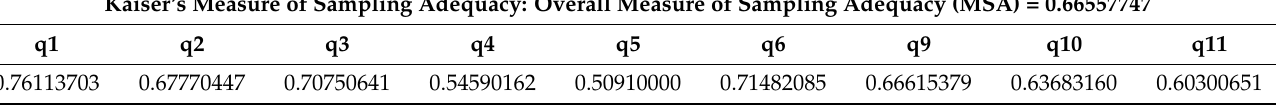
Table 3. Kaiser’s measure of sampling adequacy.